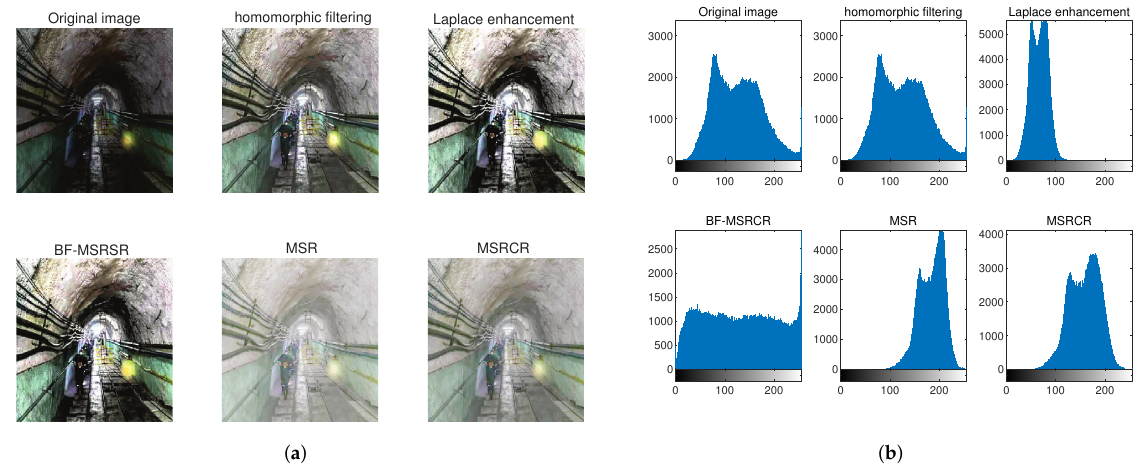
Figure 10. Image 3 algorithm and greyscale histogram comparison. ( a ) Image 3 algorithm comparison; ( b ) Image 3 algorithm and greyscale histogram comparison.